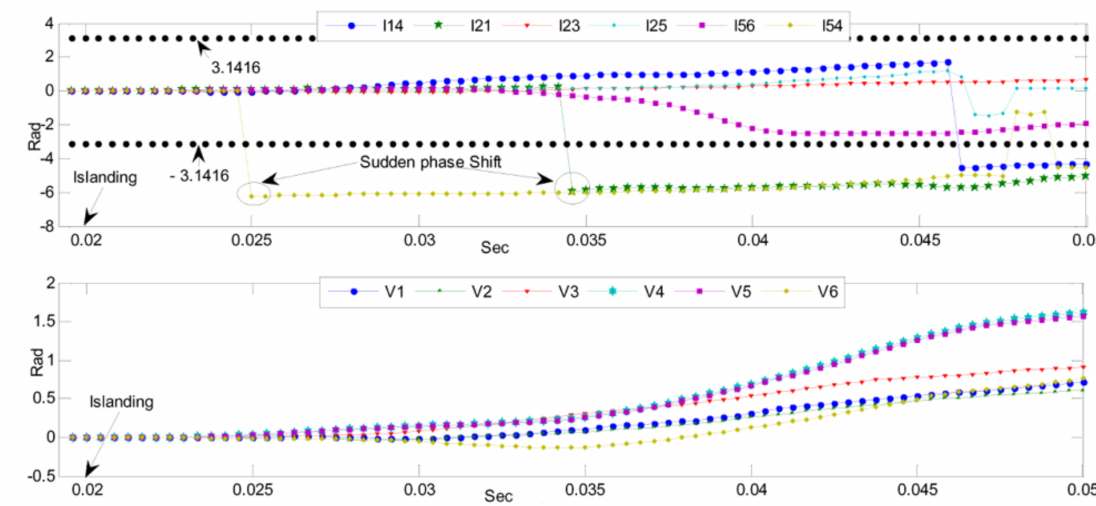
Figure 13. Current phasor and voltage phasor angle for detecting islanding events